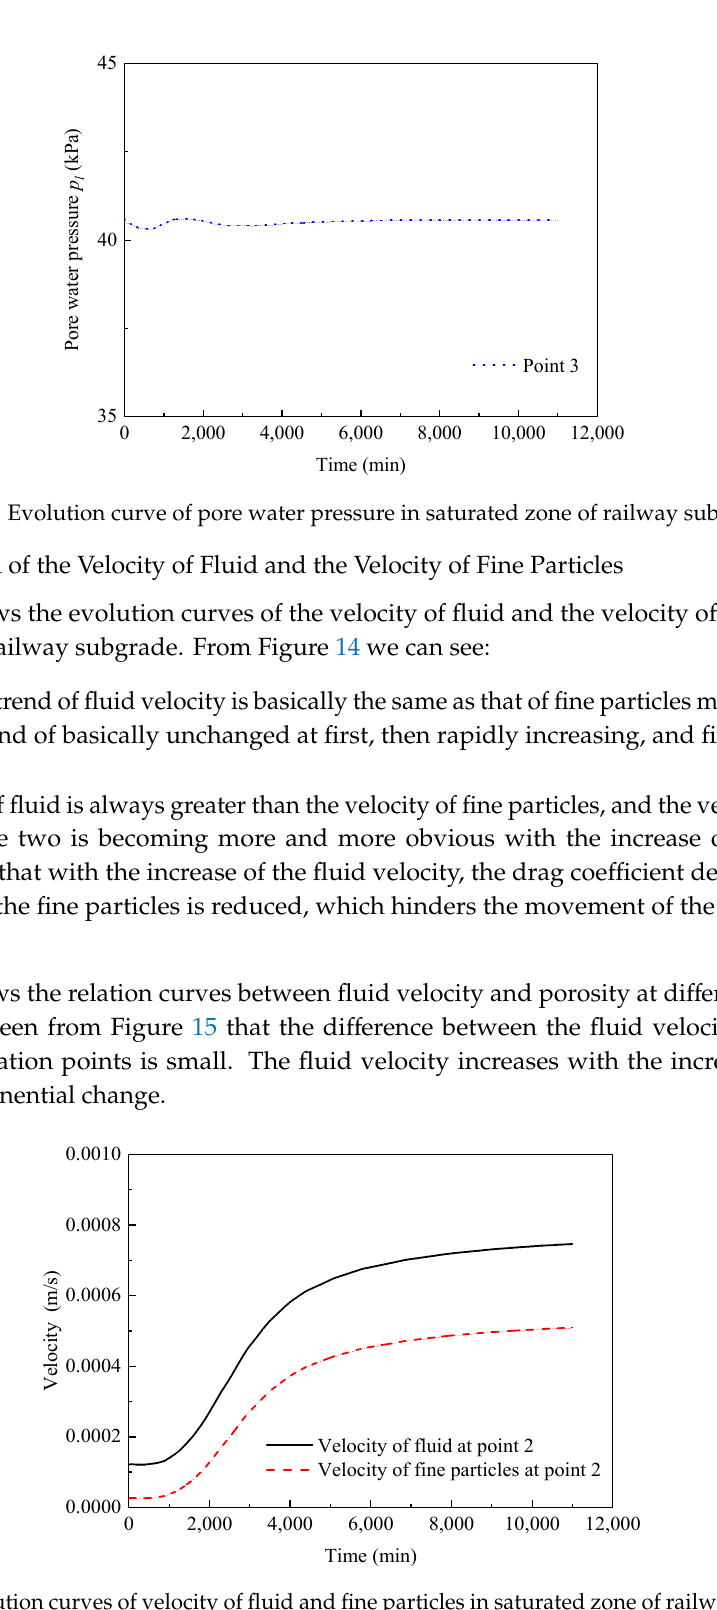
Figure 14. Evolution curves of velocity of fluid and fine particles in saturated zone of railway subgrade.